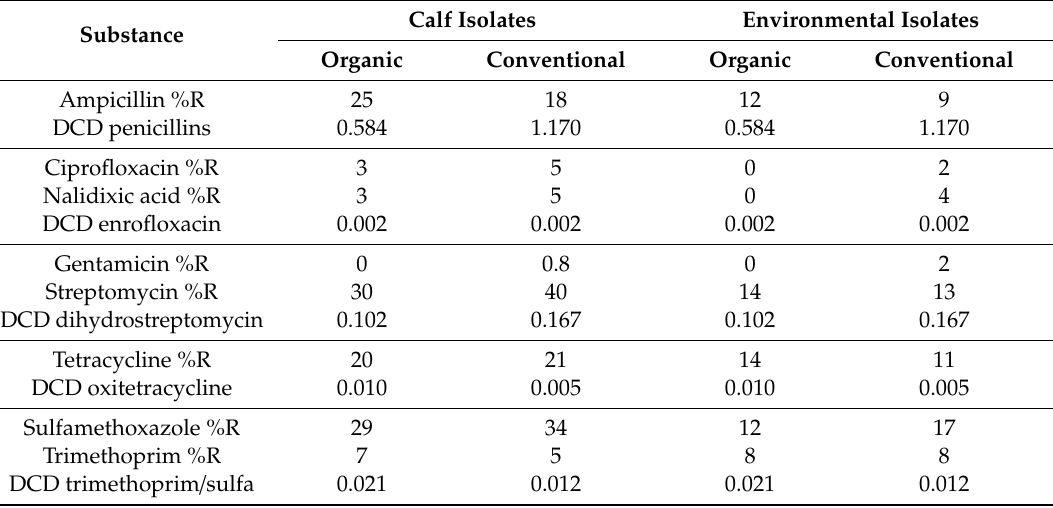
Table 2. Proportion of resistant Escherichia coli isolates from fecal samples from calves and environment (manure drainage and manure pit) in 27 organic and 27 conventional Swedish dairy herds (sampling period 2) and the corresponding use of antimicrobial treatments in these herds, as determined by collection of empty drug packages. Organic = organic herds, conventional = conventional herds, %R = proportion of resistant isolates (%), and DCD = total number of defined course doses per animal per year for the corresponding antimicrobial substance, expressed as the average figure for all herds in the category during the two data collection periods. Calf Isolates Environmental Isolates Substance Organic Conventional Organic